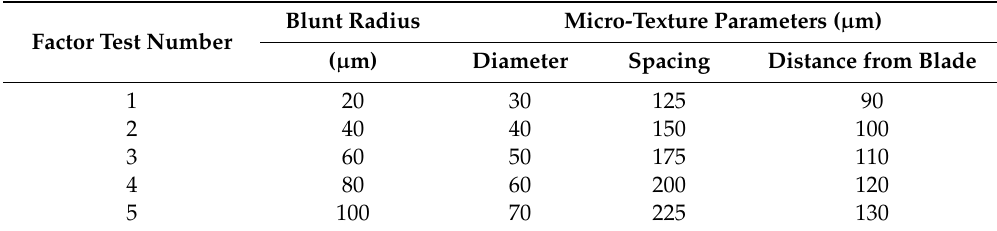
Table 2. Four factors and five levels table of the simulation parameters.